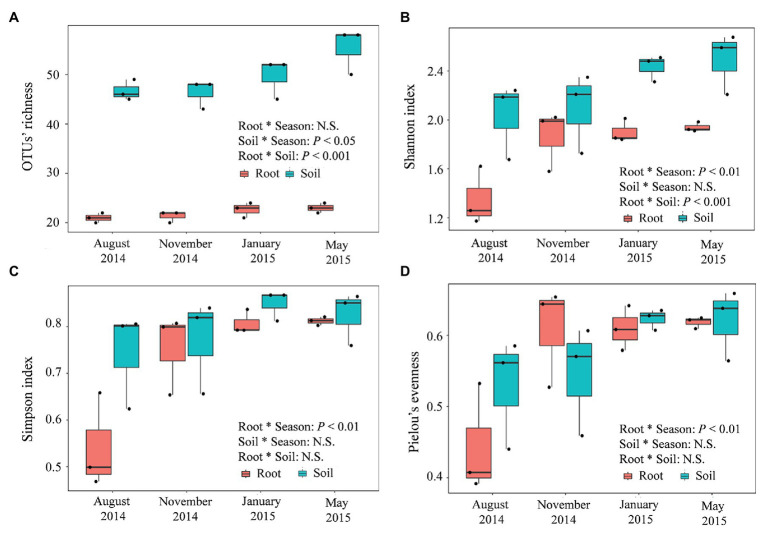
Seasonal changes in the alpha-diversities of the root-associated and rhizospheric soil fungal communities in P. tabuliformis forests located in the Qinling Mountains. (A) OTU richness, (B) Shannon, (C) Simpson, and (D) Pielou’s evenness. The horizontal bars within boxes represent the median. The tops and bottoms of boxes represent the 75th and 25th quartiles, respectively. The upper and lower whiskers extend 1.5× the interquartile range from the upper edge and lower edge of the box, respectively. N.S., non-significant.